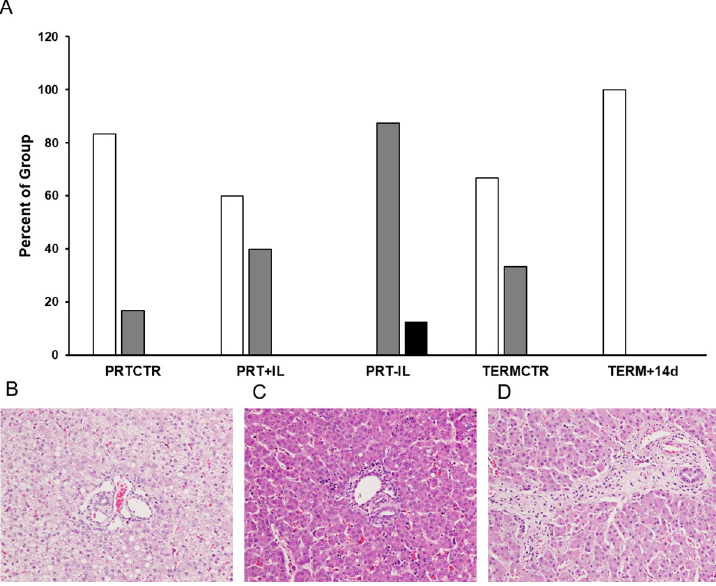
Fig 3. Hepatic fibrosis in infant baboons. [A] Percentage of baboons per group with stage 0 (white bars), stage 1 (grey bars), and stage 2 (black bars) hepatic fibrosis are shown. Trend towards increased fibrosis in PRT-IL group vs PRTCTR (p = 0.003; Kruskal-Wallis test). [B-D] Representative H&E images of each fibrosis score are also shown. Magnification is 20X for each image. [B] Fibrosis score of 0 is shown. [C] Fibrosis score of 1 is shown. [D] Fibrosis score of 2 is shown. PRTCTR: preterm gestational control, n = 6; PRT+IL: preterm with Intralipids, n = 5; PRT-IL: preterm without Intralipids, n = 8; TERMCTR: term gestational control, n = 6; TERM+14d: term gestational control surviving 14 days, n =